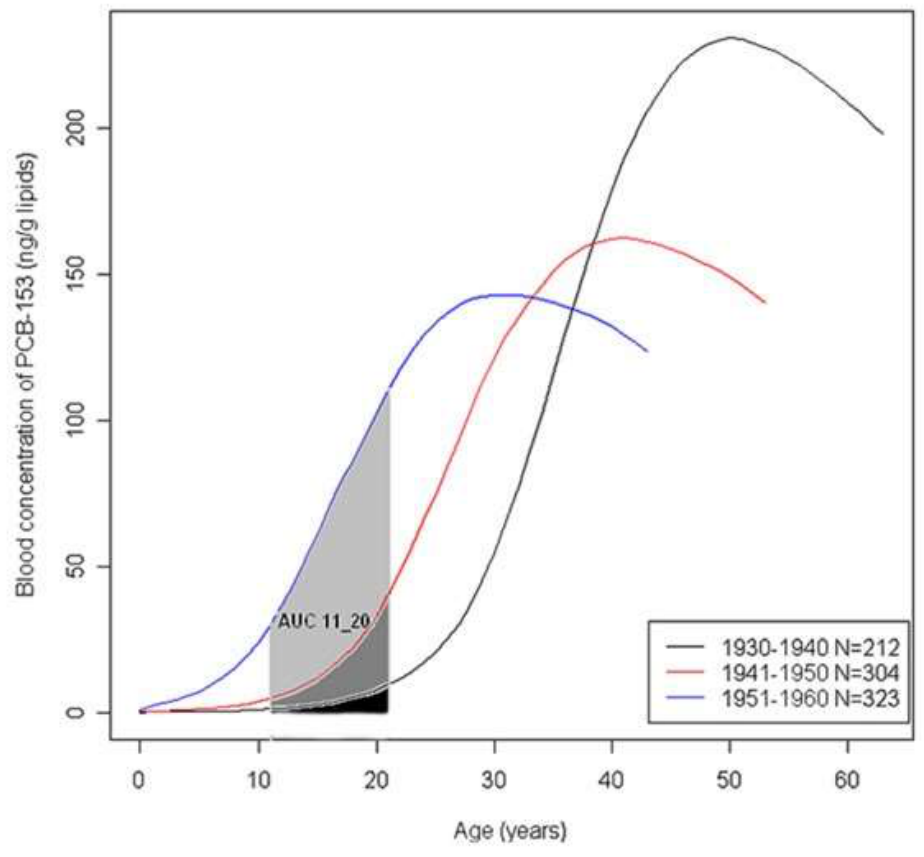
Figure 1. Mean lifetime toxicokinetic profiles according to the birth cohort. AUC 11_20 is the area under the PBPK-derived PCB153 concentration curve for the age period 11 to 20 years. Odds ratios associated with PBPK-derived estimates of PCB153 exposure during adolescence were calculated after stratification by birth cohort (Table 4). Analysis of estimates for all women combined was not applicable because there was little overlap between the exposure distributions by birth